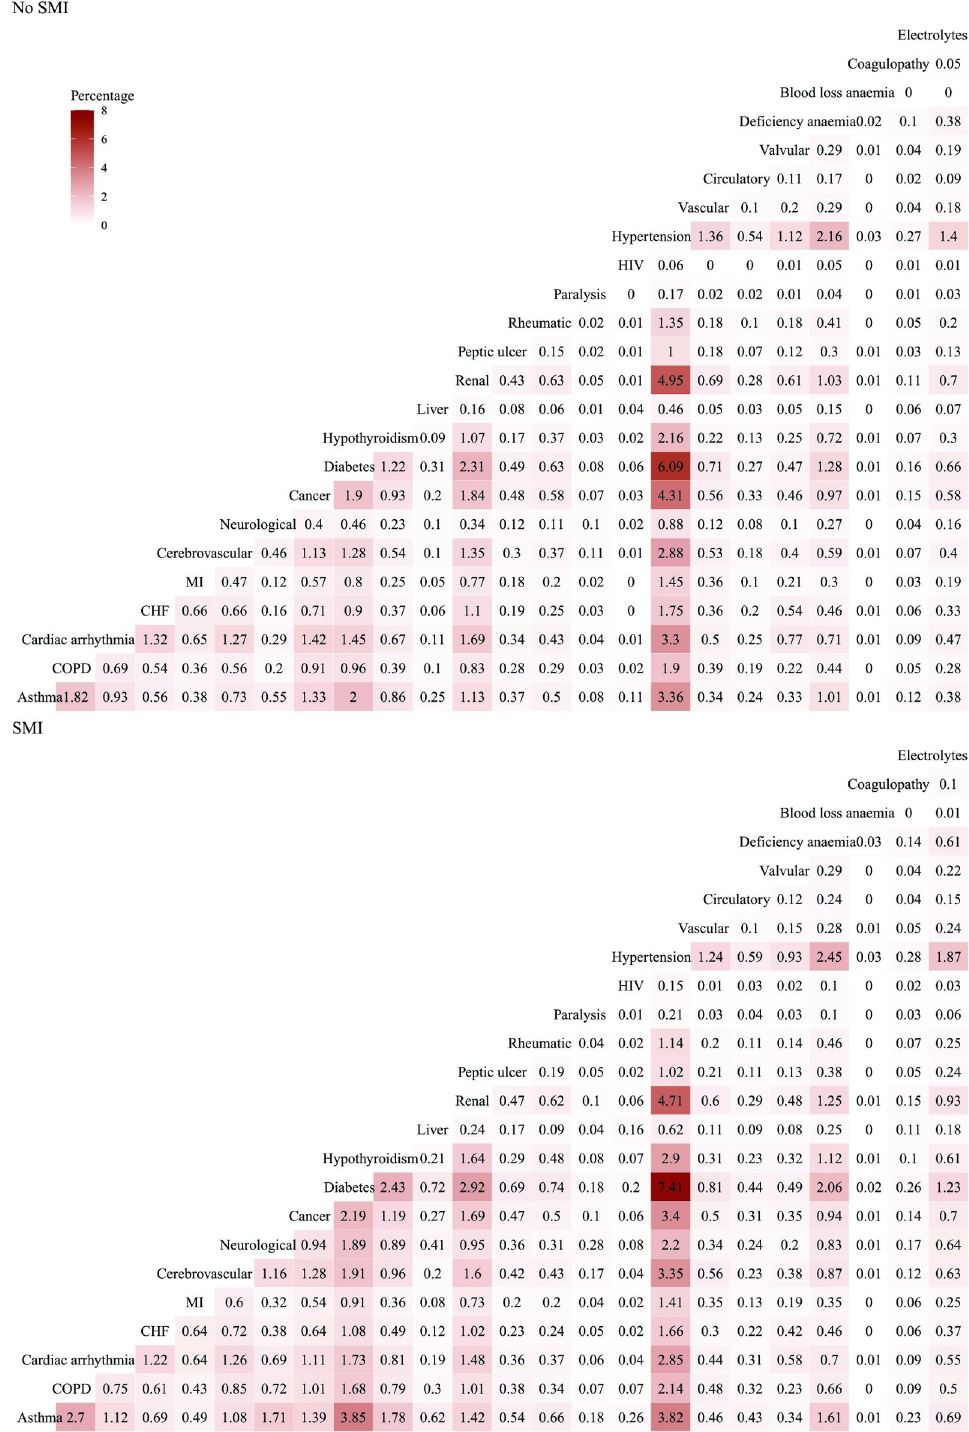
Fig 2. Percentage of patients with each combination of physical health condition pairs in patients with SMI and matched comparators. CHF, congestive heart failure; circulatory, pulmonary circulation disorders; COPD, chronic obstructive pulmonary disease; electrolytes, fluid and electrolyte disorders; HIV, human immunodeficiency virus; MI, myocardial infarction; paralysis, paresis/paralysis; rheumatic, rheumatic and collagen disease; SMI, severe mental illness; vascular, peripheral vascular disease.